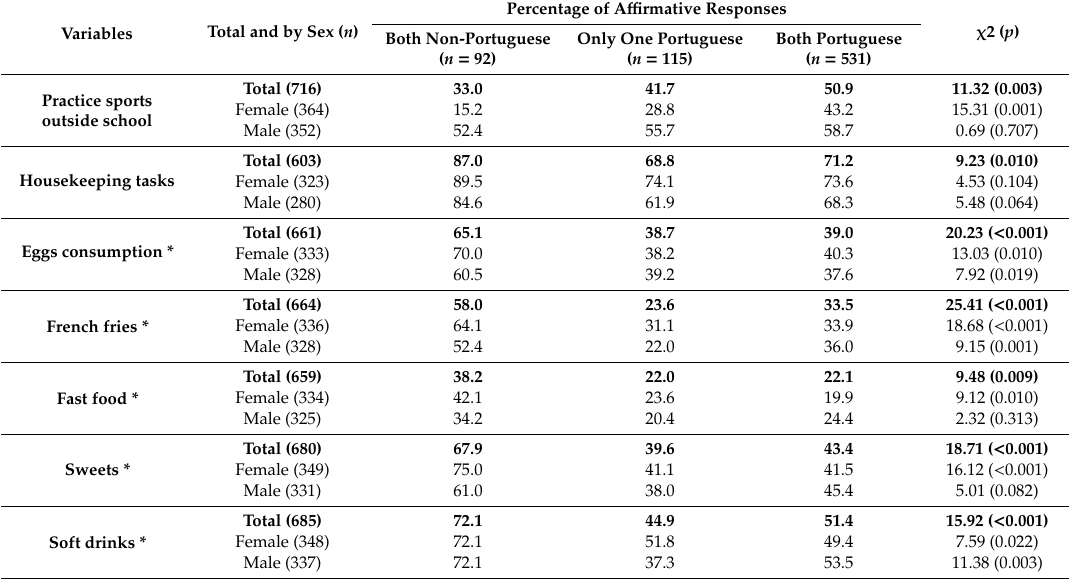
Table 5. Practice sports, housekeeping tasks, and food consumption according to parents’ origin, for total sample and stratified by